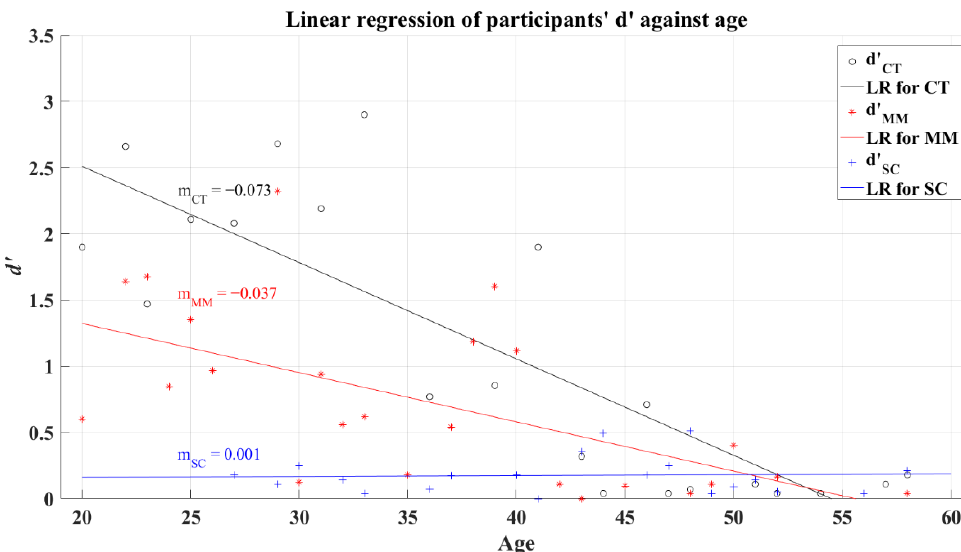
Figure 10. Linear regression of participants’ average d’ versus age for 2AFC-P2. Black line—linear regression for Control group (LR for CT); red line—linear regression for Mild-Moderate post-COVID group (LR for MM); blue line—linear regression for Severe-Critical post-COVID group (LR for SC); 𝑑′ (cid:3004)(cid:3021) , Control group’s efficiency index; 𝑑′ (cid:3014)(cid:3014) , Mild-Moderate group’s efficiency index; 𝑑′ (cid:3020)(cid:3004) , Severe-Critical group’s efficiency index; 𝑚 (cid:3004)(cid:3021) , Control group’s slope; 𝑚 (cid:3014)(cid:3014) , Mild-Moderate group’s slope; 𝑚 (cid:3020)(cid:3004) , Severe-Critical group’s slope.